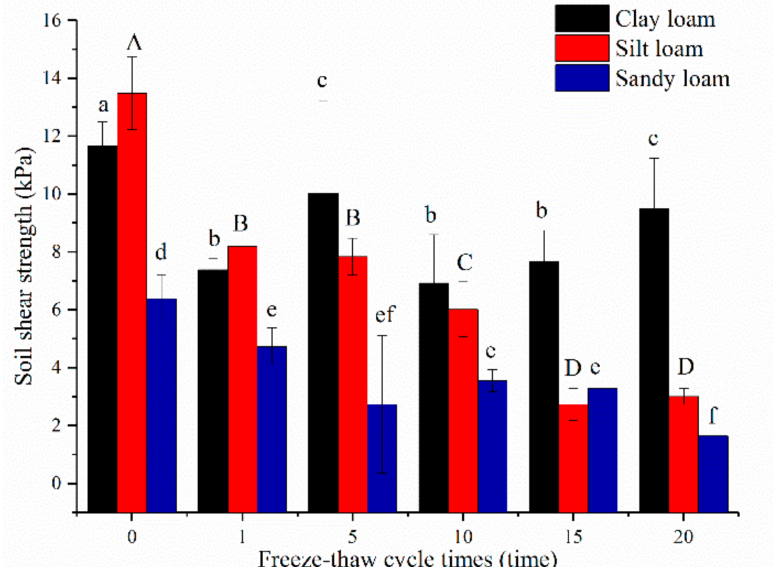
Figure 6. Relationships between soil shear strength and freeze-thaw cycles of three soils. Note: The letters indicated whether the differences in the test results were significant or not. “a, b, c” stands for clay loam, “A, B, C, D” stands for silt loam, “d, e, f” stands for sandy loam. Different letters indicate a significant difference of test results among the different freeze-thaw cycles and soils at the 0.05